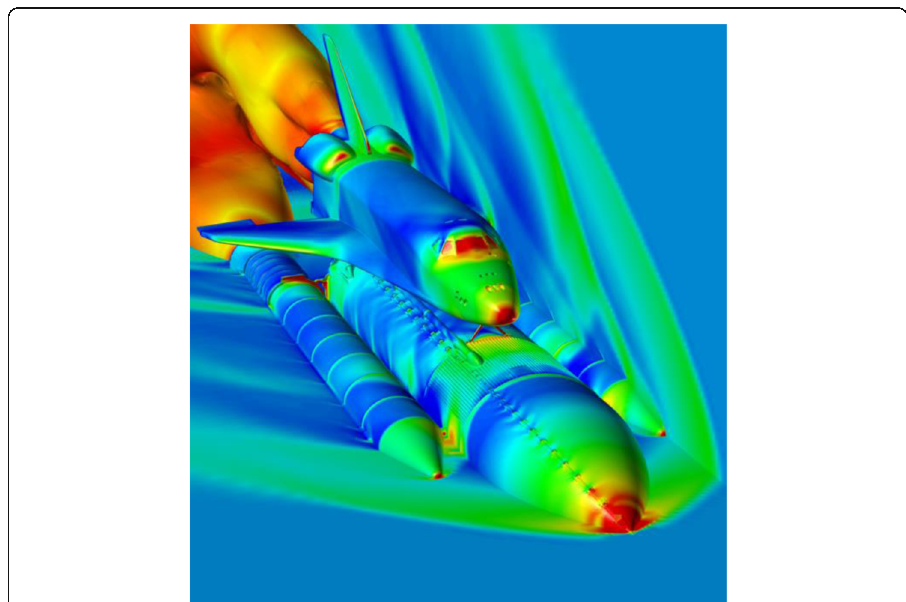
Fig. 10 CFD simulation of space shuttle launching configuration